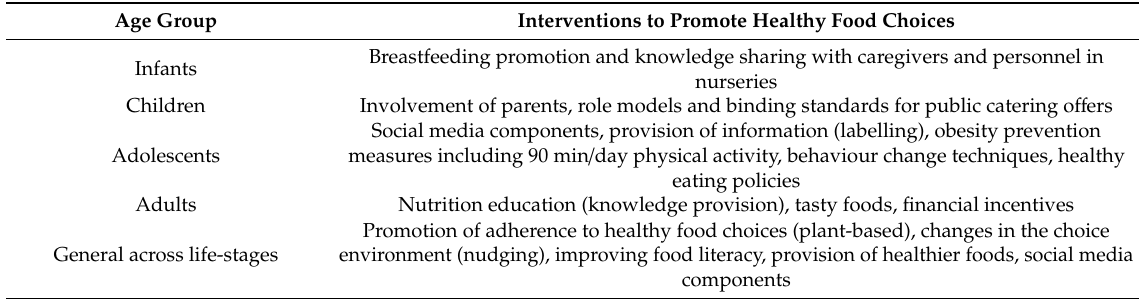
Table 2. Synthesis of interventions to promote healthy eating by age